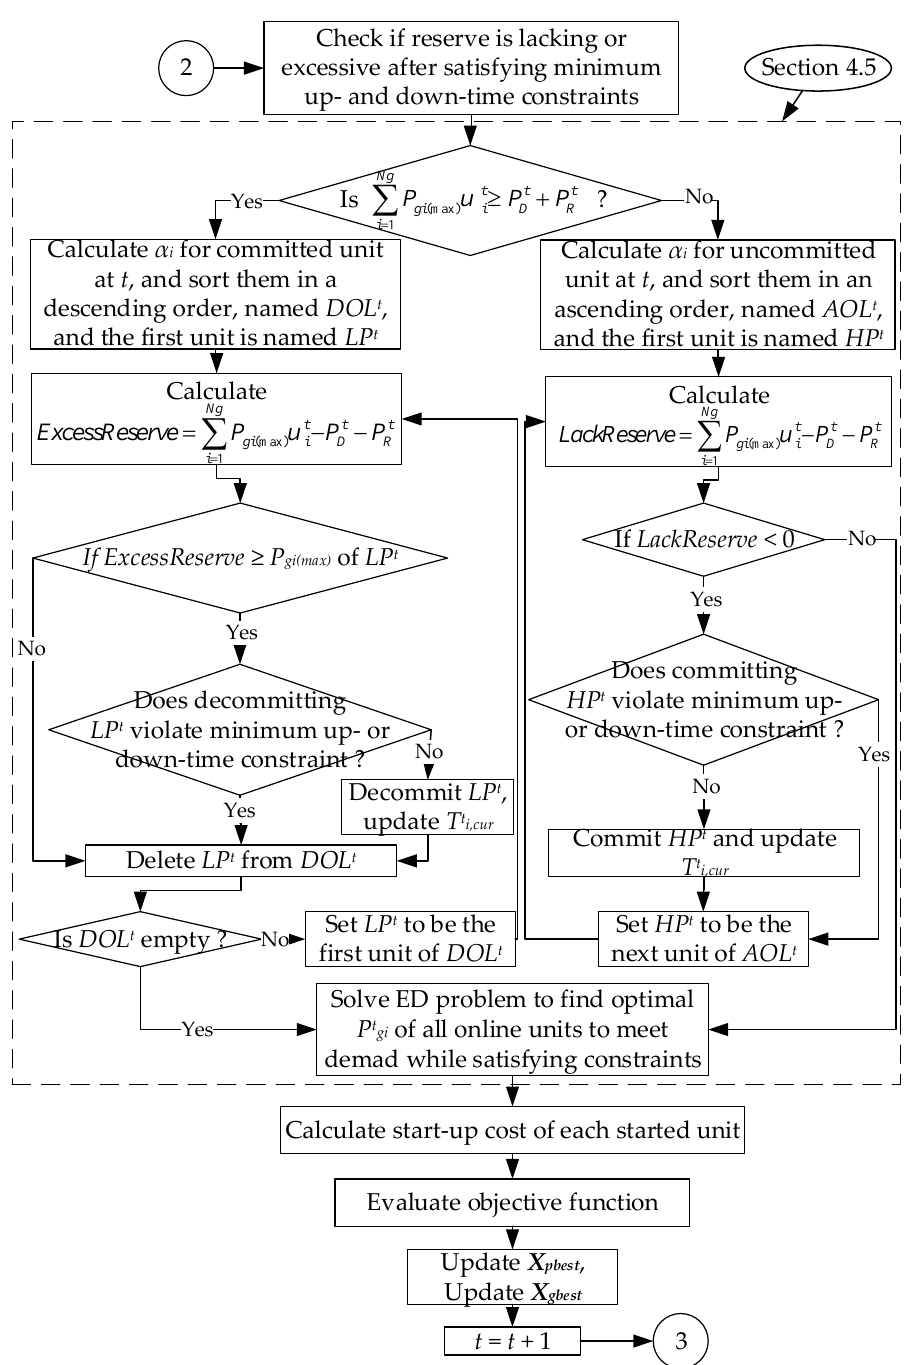
Figure 1. Flowchart of Improved Dragonfly Algorithm-Particle Swarm Optimization (iDA-PSO) Figure 1. Cont. approach for Unit Commitment (UC)